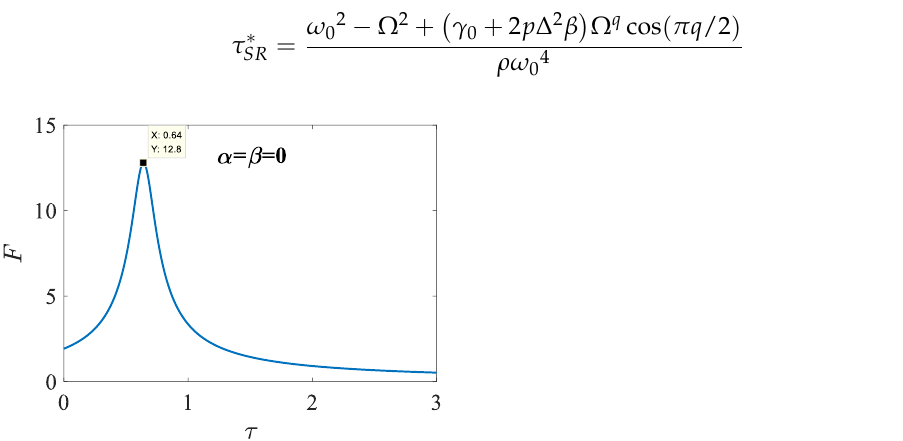
Figure 7. Delay induced GSR under noiseless situation in system (42) according to Equation (38).